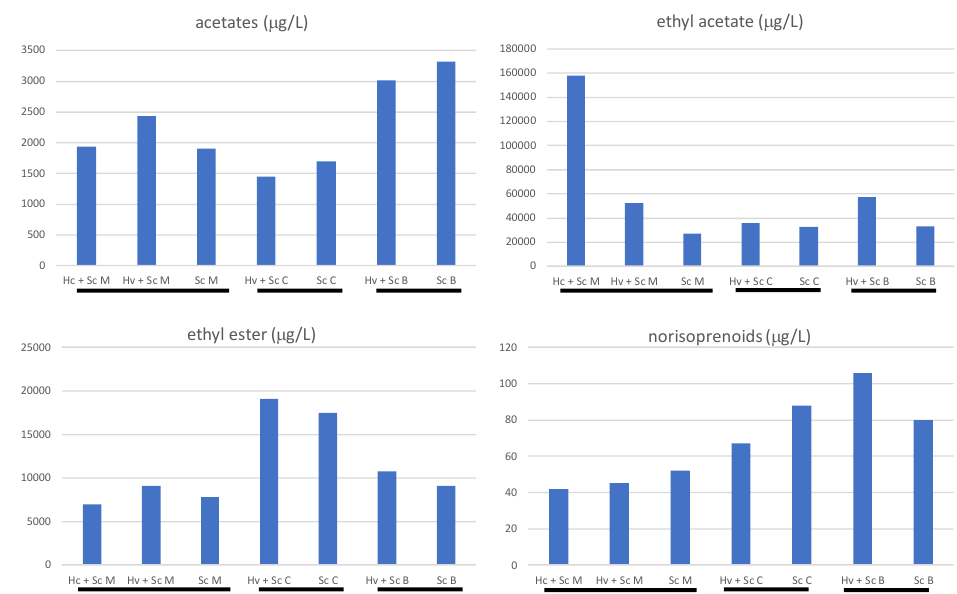
Figure 7. Concentration of principal groups of volatile compounds in vinifications at semi-pilot (M), pilot (C) and industrial (B) scale. Vinifications were inoculated with Hanseniaspora vineae (Hv), Hanseniaspora clermontiae (Hc) and Saccharomyces cerevisiae (Sc).